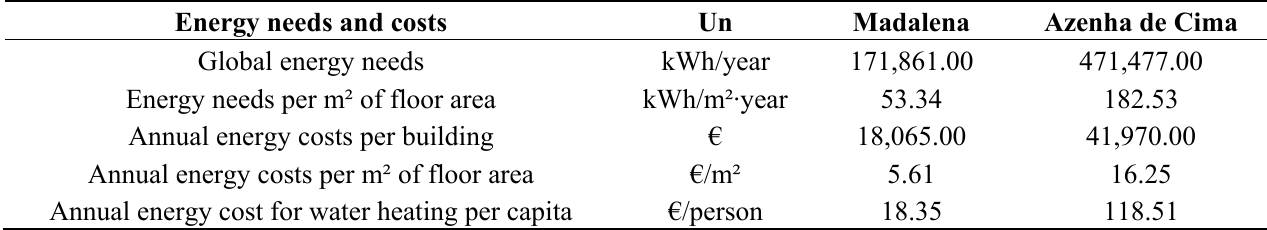
Table 8. Description of energy demands costs—Madalena vs . Azenha de Cima.